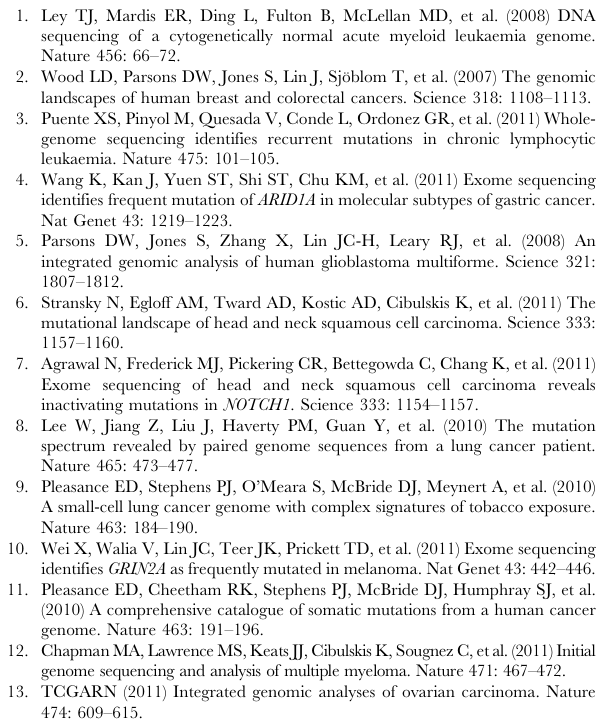
Table S10 Individual patient samples harboring genes with $ 4 NS substitutions. Sequence context-dependency of patient samples which experienced $ 4 NS substitutions in the same gene. White background , SBSs at DGNN sequences; white on black background , SBSs at CGNN sequences; gray background , SBSs at NANN sequences; bold , SBSs at DGRN sequences. Fraction of NGNN sequences: 30/35=86%). (DOCX) Text S1 Supporting information. The text contains information on the distribution of NGNN sequences in the mappability files and in Segmental Duplications, a description of mutational mechanisms shared by similar cancer types and individual samples, the analysis of recurrent non-synonymous substitutions, and exemplary scripts for obtaining the fractions f i of mutated NGNN